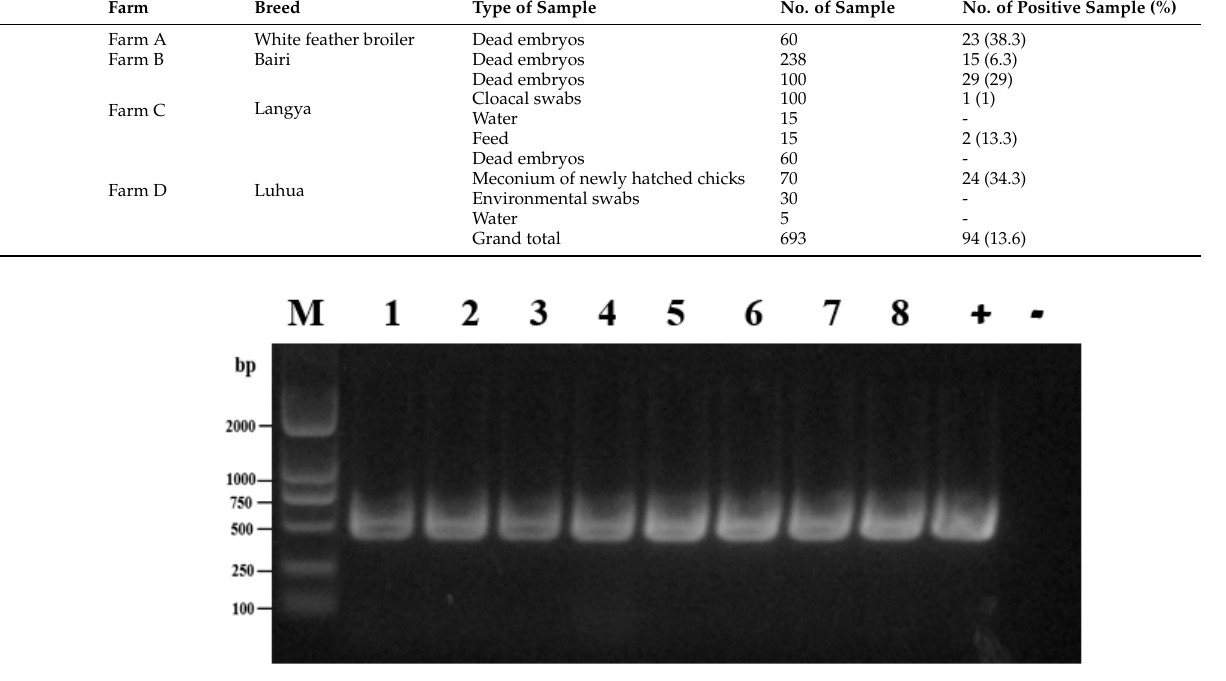
Table 1. Number of samples and prevalence of Salmonella in Poultry farms ( n = 693).